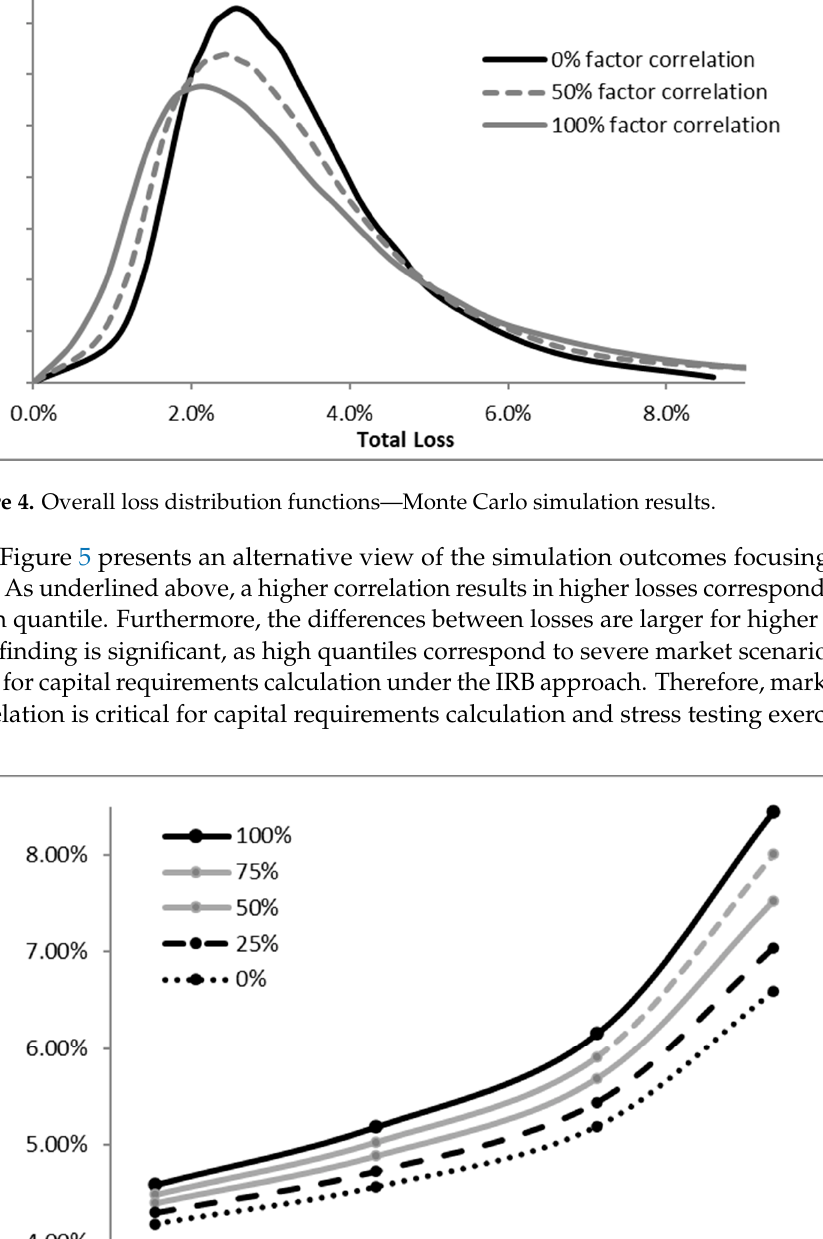
Table 2. Total loss results corresponding to various quantiles and factor correlation.